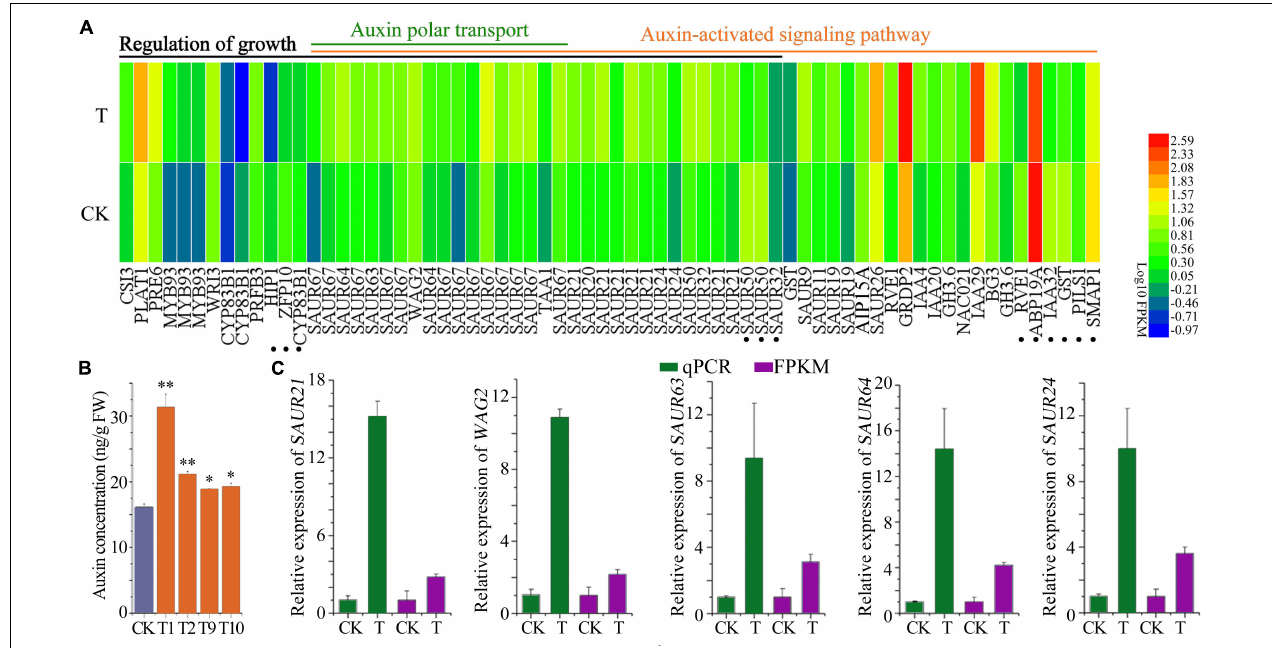
FIGURE 8 | Auxin signaling pathway was affected in the PTPRPF1::FvTST1 lines (A) DEGs related to “Regulation of growth,” “Auxin-activated signaling pathway,” and “Auxin polar transport.” (B) Auxin concentration in transgenic seedlings and control. (C) qPCR verification of several genes involved in auxin signaling pathway. The dot represents the twelve genes that are responsible for growth enhancement, but not the members of auxin signaling pathway. Values are means ± standard deviation of three biological replicates. The SPSS software (v19.0) was used for one-way ANOVA ( ∗ p < 0.05 ; ∗∗ p <